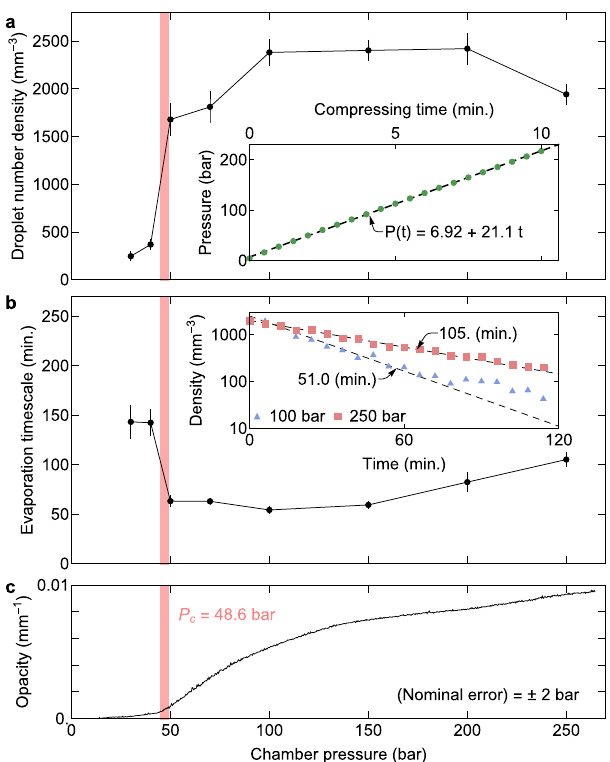
Fig. 3 Presence of droplets and clusters. a The number density of droplets generated by the continual compression of argon fl uid in the high-pressure chamber. The droplet number density does not increase as the pressure exceeds 100 bar because the temperature drop is not large enough to form a liquid at a higher chamber pressure (i.e., a smaller pressure difference between the chamber and check valve) and the droplets evaporate. The number density of droplets decreases due to evaporation in the medium. b The evaporation timescale at different pressures. c The major contribution to medium opacity comes from clusters. The error bars are the standard deviations of each